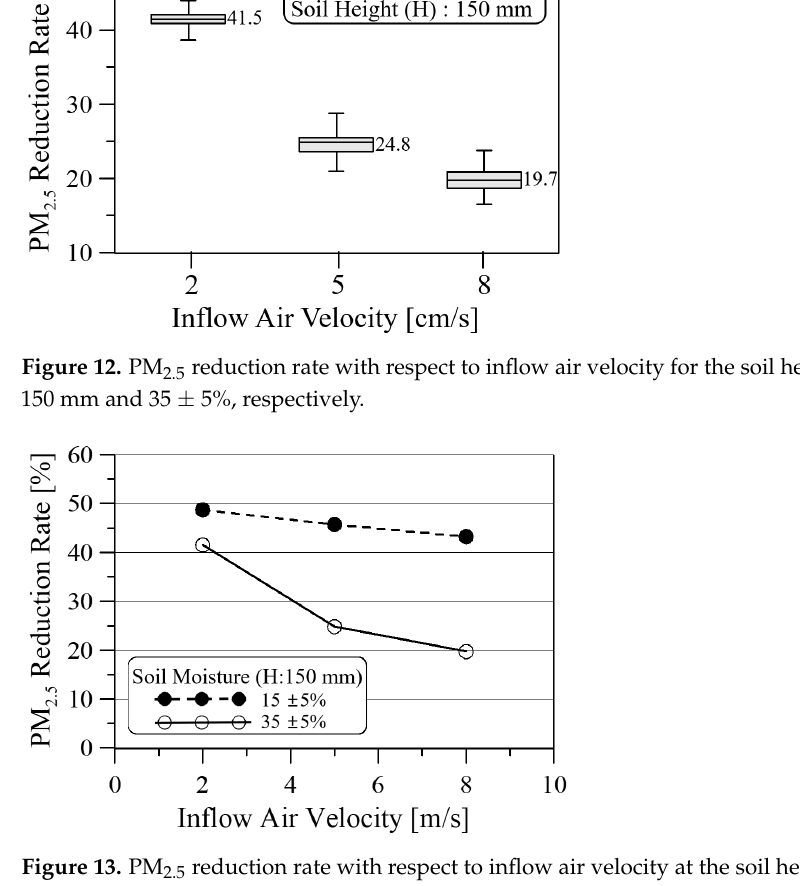
Figure 12. PM 2.5 reduction rate with respect to inflow air velocity for the soil height and moisture of 150 mm and 35 ± 5%, respectively.